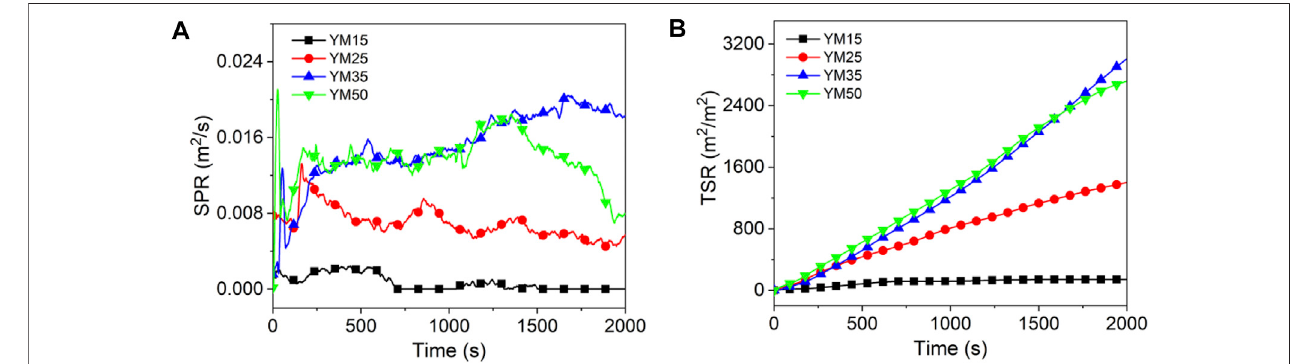
FIGURE 5 | Bitumite curves: (A) SPR, and (B) TSR.